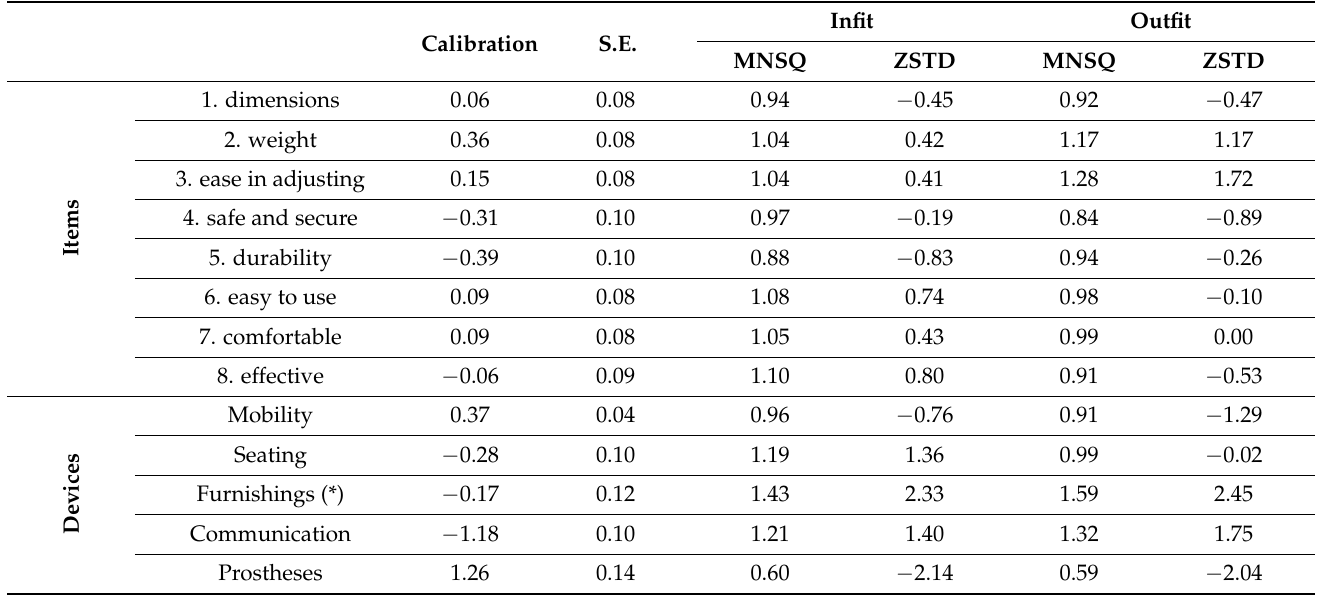
Table 3. Calibration and fit to the model of the QUEST